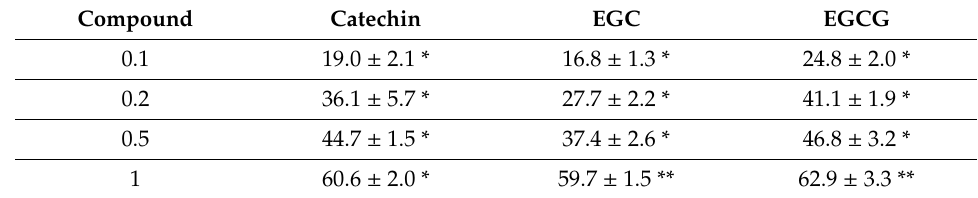
Table 6. Protection by monomeric flavanols against hypochlorite-induced erythrocyte membrane lipid peroxidation. * p < 0.05, ** p < 0.01 (with respect to